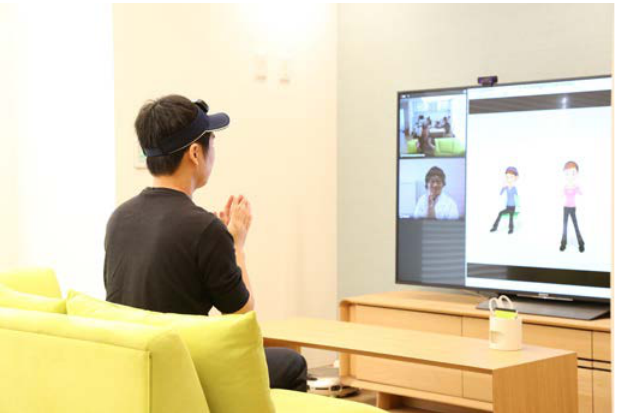
Figure 4 Example of an information assist system (Commu-TV, Brother Industries,